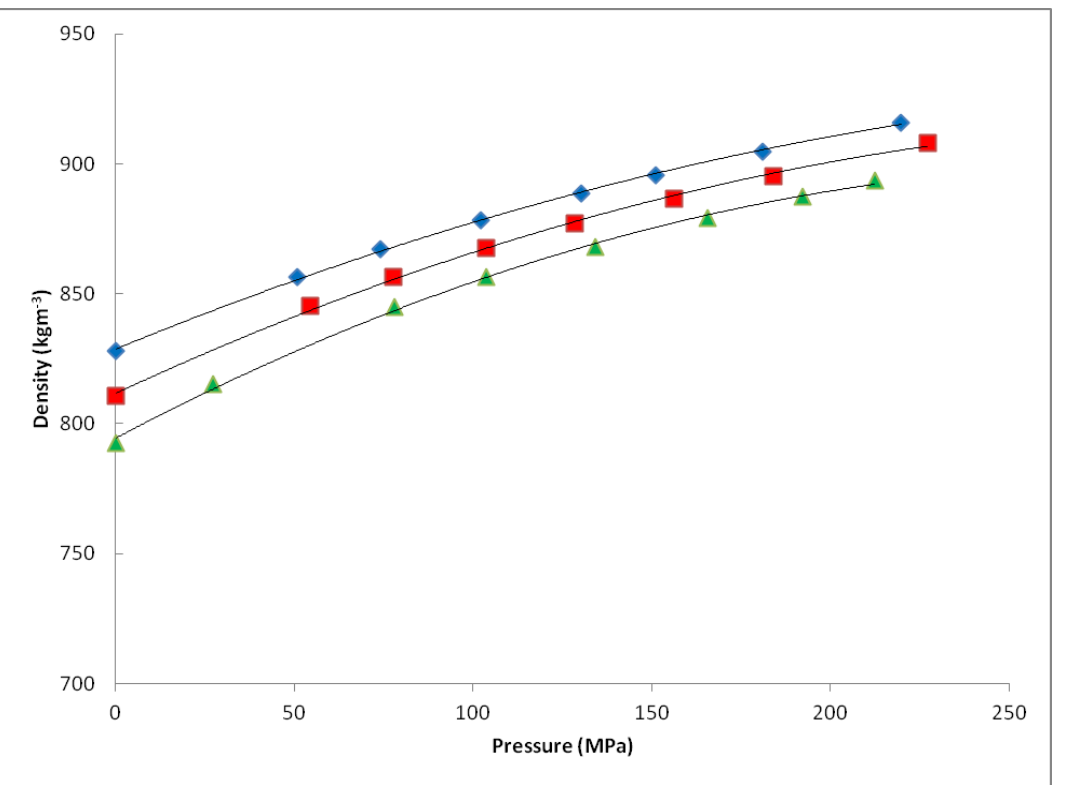
Figure 9. Variation of density for Fuel 4 with temperature. ♦ 298 K, ■ 323 K, and ▲ 348